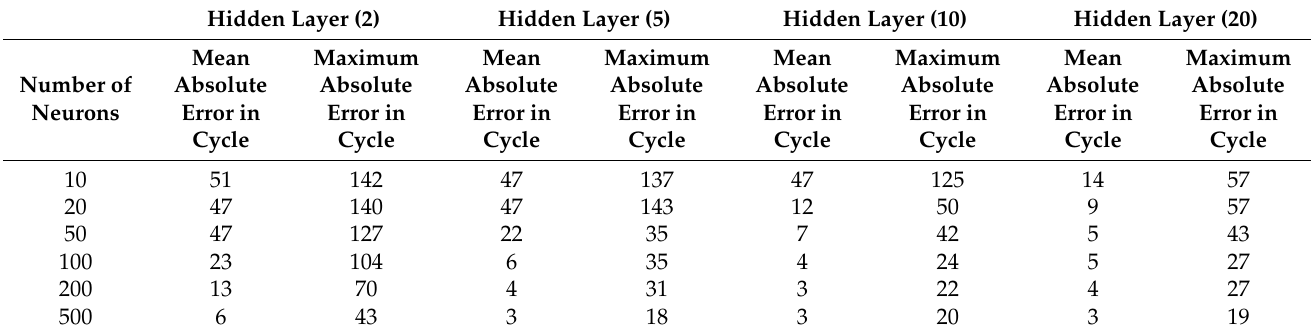
Table 9. Comparison results of FEM and ANN models on 1296 training datasets.